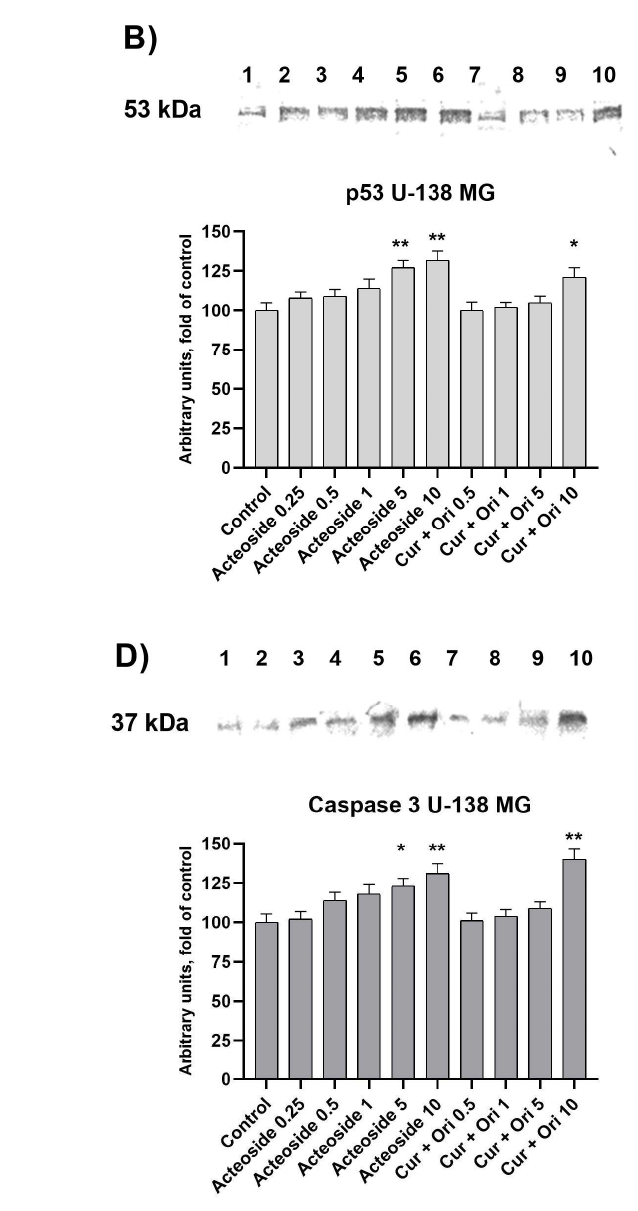
Figure 11. The effect of ACT and CUR+ORI on the protein level of p53 in panels ( A ) and ( B ) and caspase-3 in panels ( C ) and ( D ) in GBM cells. Data are presented as mean ± SEM. * represents p < 0.05, ** represents p < 0.01, compared with the untreated group. The values in the x axes are concentration in µ M of ACT or the 1:1 molar mixture of CUR + ORI. The representative immune blot respectively for Figure 11 show in Figures S1–S4.